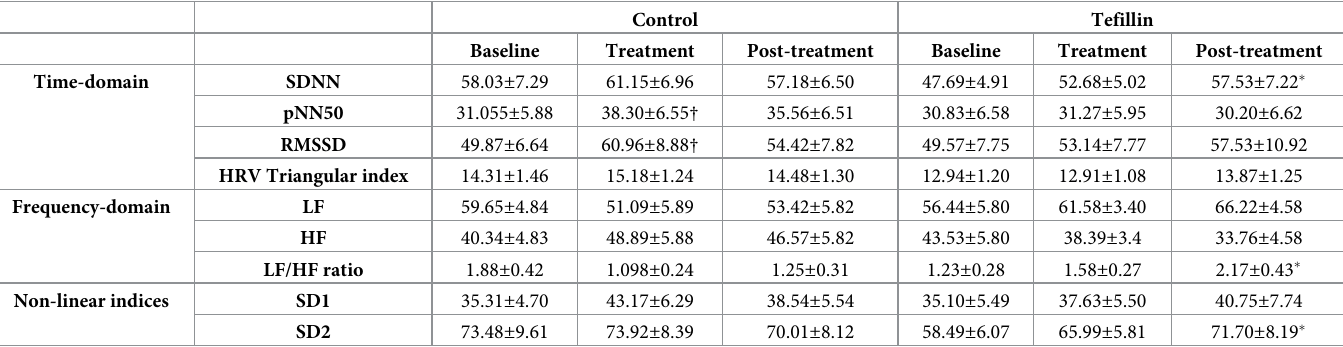
Table 2. Average absolute values for HRV measurements.